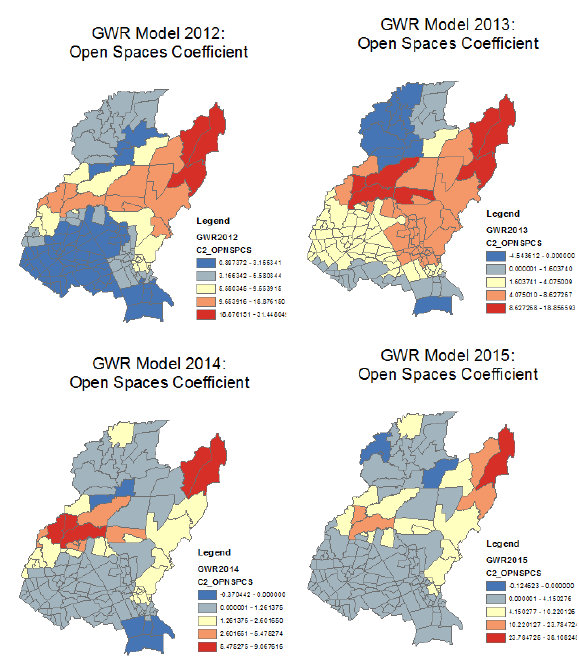
Figure 8. Map of the coefficients of open spaces as predictor for each GWR model from 2010 to 2015.